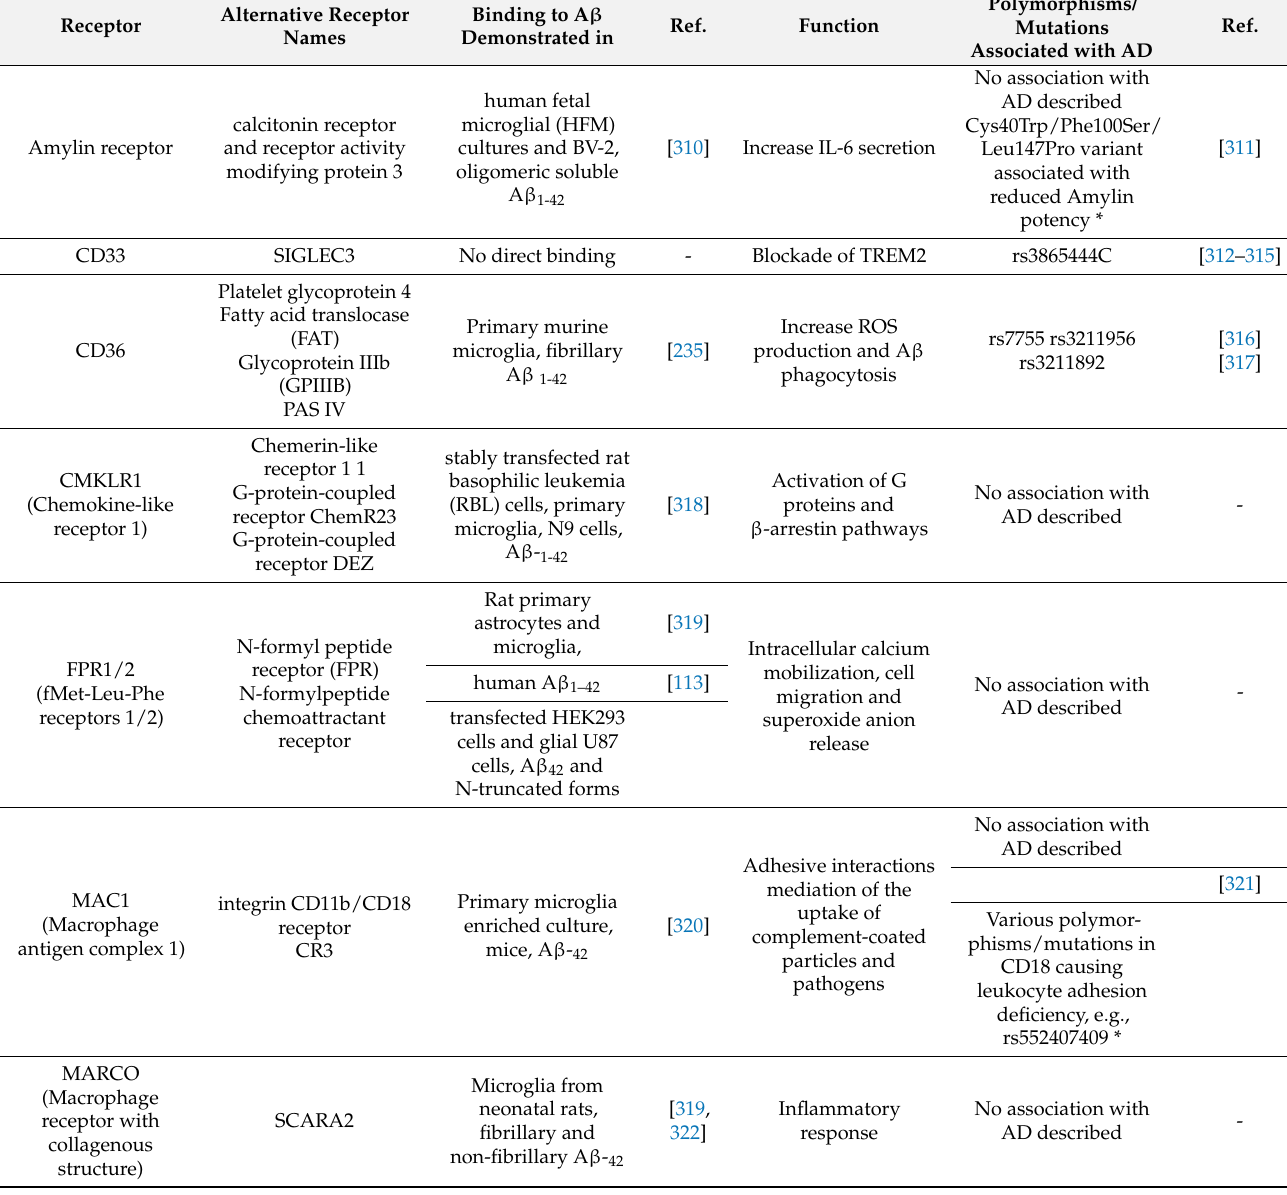
Table 2. Microglial A β -binding/binding-modulating receptors and identified AD-associated polymorphisms and mutations. Search for polymorphisms and mutations was conducted using PubMed text search or UniProt https://www.uniprot.org/uniprotkb/.../entry#disease_variants, accessed from 20 June to 4 August 2022. * In the case that no association with AD has been described yet, known polymorphisms or mutations affecting receptor functions are